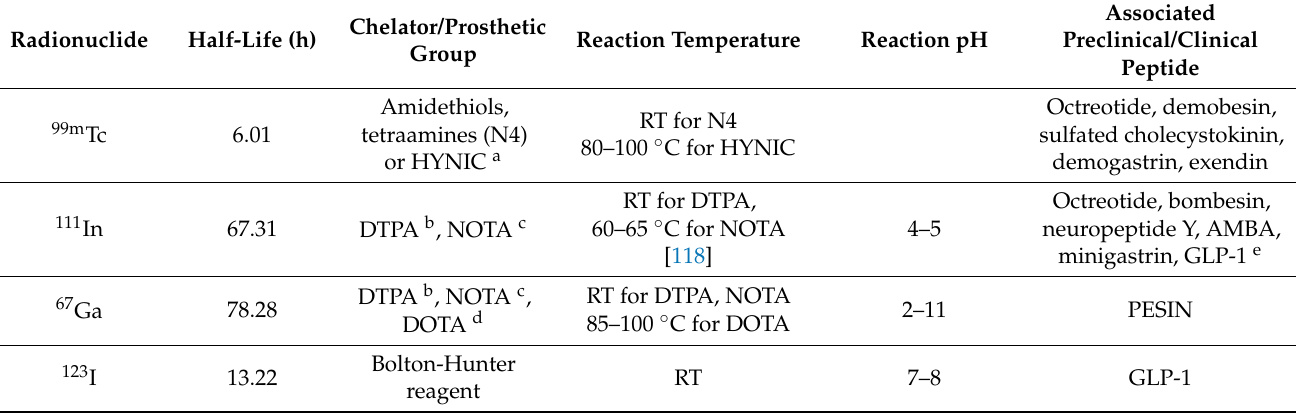
Table 2. Summary of SPECT radionuclides and reaction parameters used in the preparation of radiolabeled peptides for pre-clinical and clinical imaging [105,114–117]. a Hydrazinoni- cotinic acid; b diethylenetriaminepentaacetic acid; c 1,4,7-triazacyclononane-1,4,7-triacetic acid; d 1,4,7,10-tetraazacyclododecane-1,4,7,10-tetraacetic acid; e glucagon-like-phosphate-1